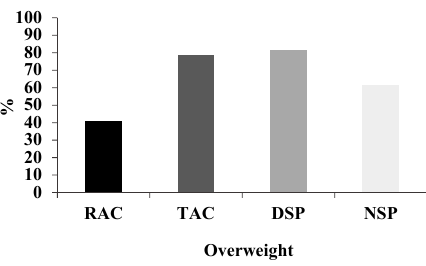
Figure 1. Percentage overweight among urban and rural workers in Acre (AC) and São Paulo (SP). Rural = RAC, town = TAC, city-day workers = DSP and city-night workers = NSP. Overweight = BMI > 30 kg/m 2 . Fisher’s exact test revealed differences between groups, p = 0.04.